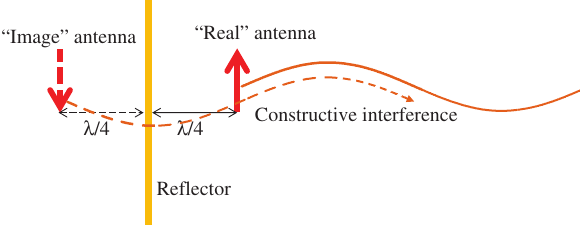
mode convertors for circular vector beams [64] and